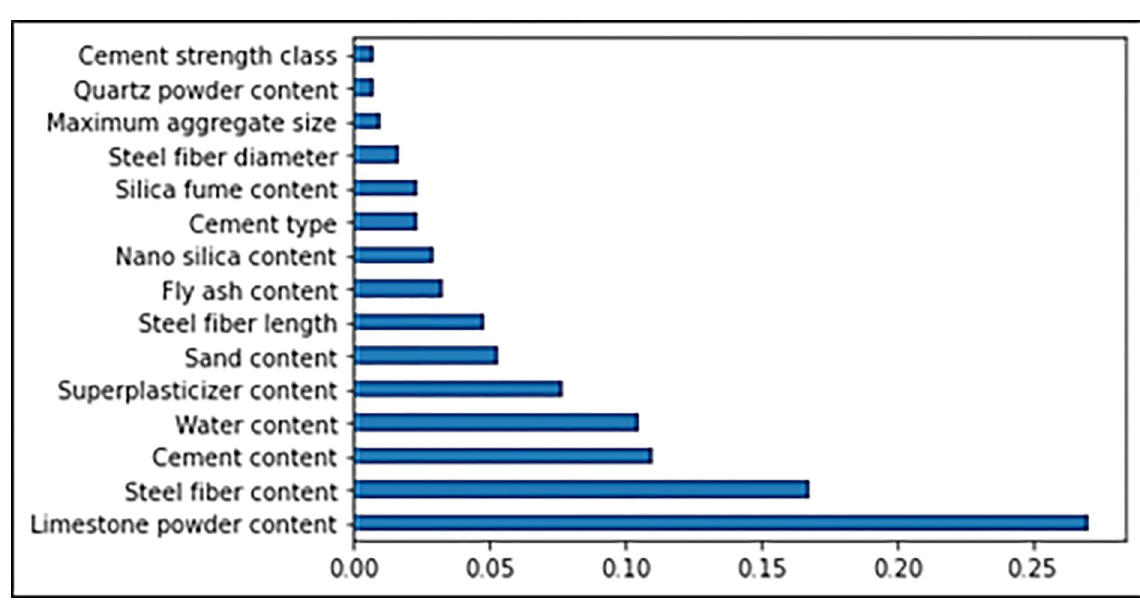
Fig 20. Feature importance of flowability.